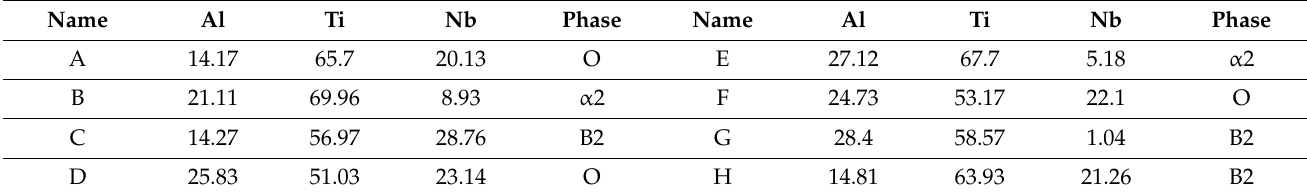
Table 3. Results of local elemental analysis of the surface (at.%).